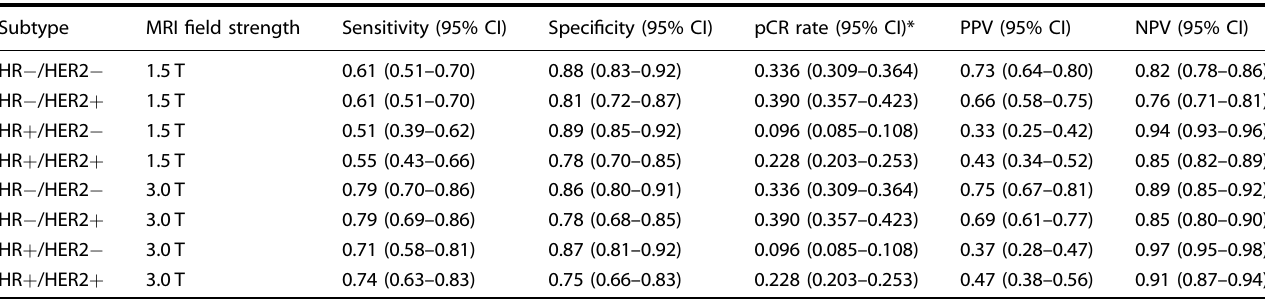
Table 2. Estimates for each of the scenarios from the meta-regression model including IHC subtype and MRI fi eld strength.